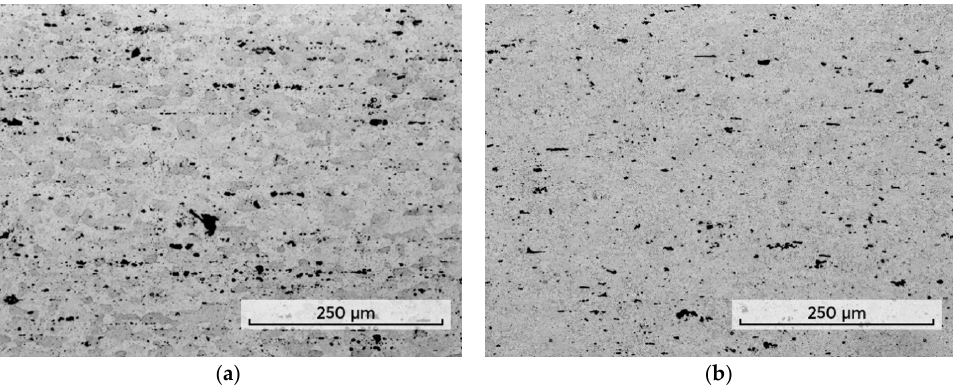
Figure 1. Microstructures of base material: ( a ) optical image transverse to the rolling direction; ( b ) optical image in longi- tudinal direction (rolling direction).